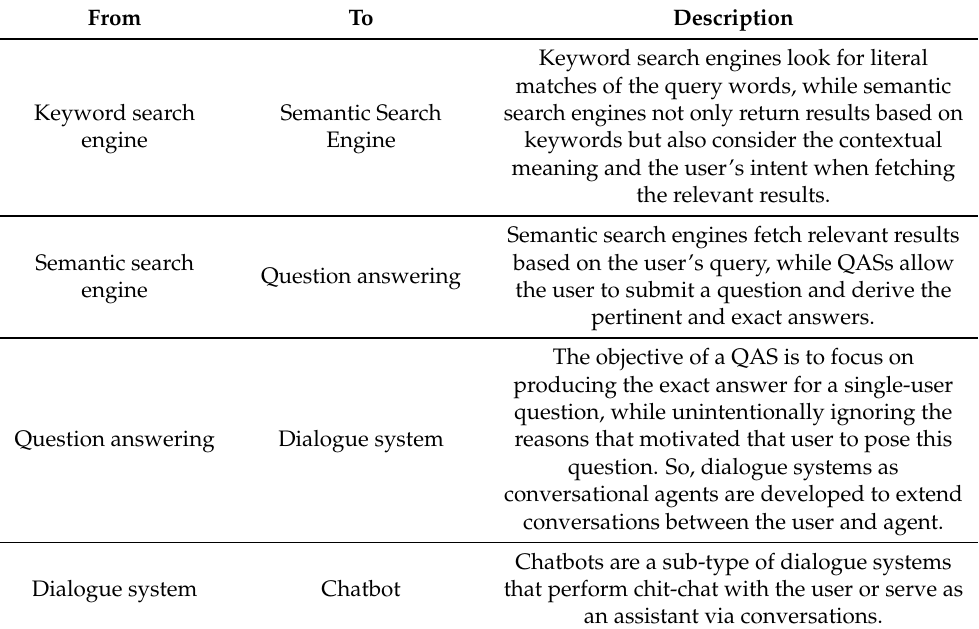
Table 1. Evolution among different search services. From